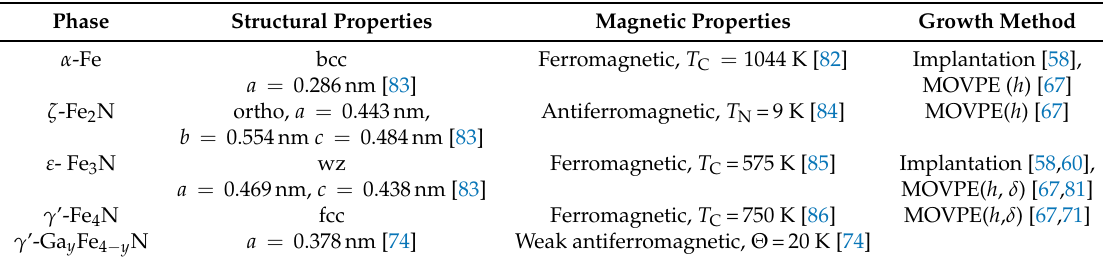
Table 2. Observed secondary- phases in Ga 1 − x Fe x N, their structural and magnetic properties, as well as the growth technique employed for the growth of the phase-separated layers.